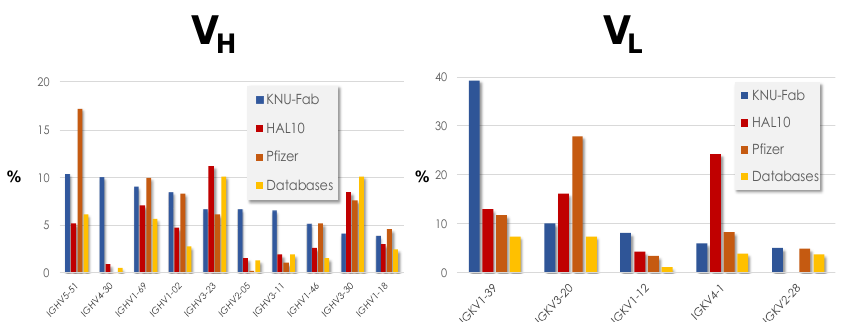
Figure 2. Use frequency of the most prevalent genes reported by KNU-Fab and HAL10. Glanville’s [53] study of the gene usage of Pfizer’s naïve library and antibody sequences collected in the antibody sequence databases is also